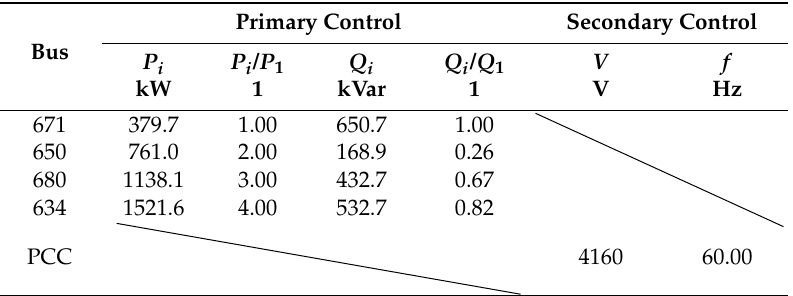
Figure 15. PCC voltage and frequency in Scenario II. Table 6. Summary of Simulation Results in Scenario